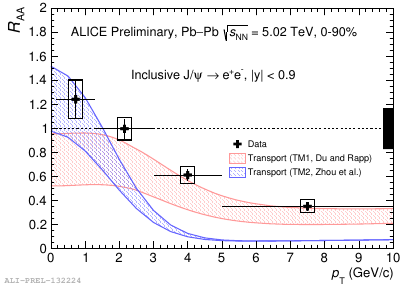
Figure 2. The nuclear modification factor in the 0–90 % centrality range as function of p T compared to two transport models [14, 16, 17].